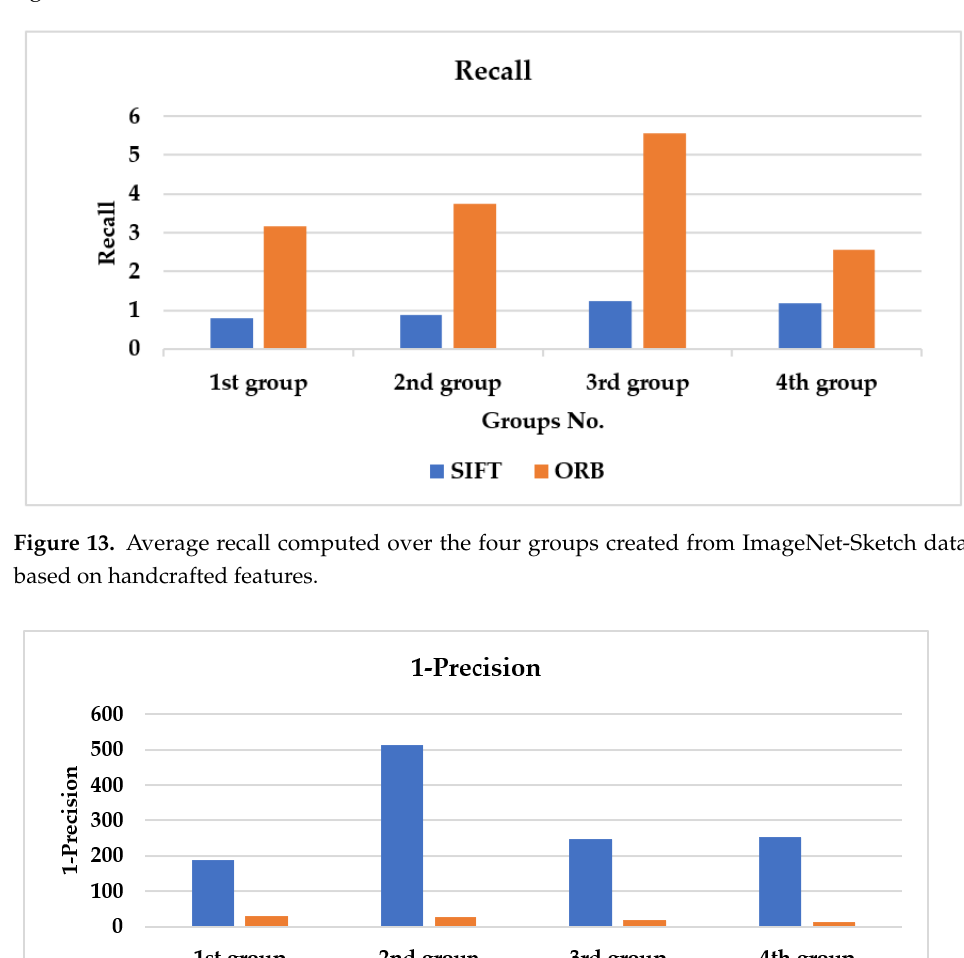
Figure 12. Time consumed for feature extraction over the four groups created from ImageNet- Sketch dataset using handcrafted features.